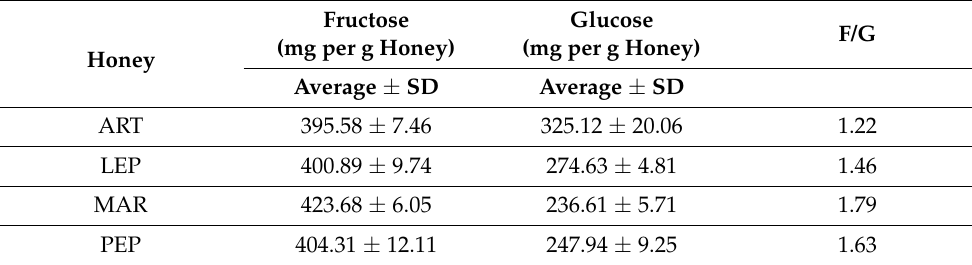
Figure 12. HPTLC images taken under white light after derivatisation with aniline-diphenyla- phosphoric acid reagent; Track 1—standards (fructose, maltose, sucrose and glucose in increasing Rf values), Track 2—ART, Track 3—MAN, Track 4—MAR, Track 5—PEP; 2 µ L of aqueous methanolic solution each. Table 3. Fructose and glucose content in different honeys.